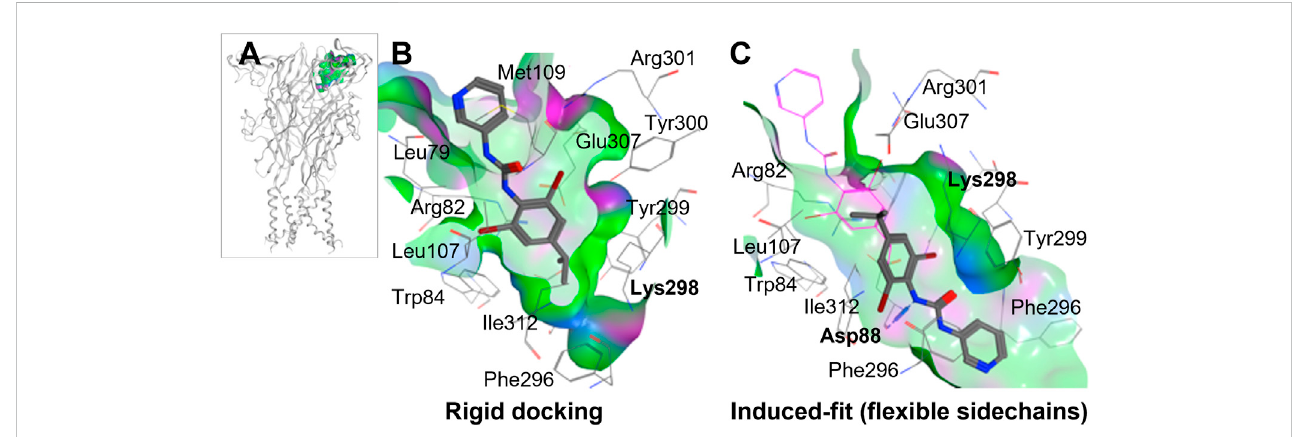
FIGURE 2 Molecular docking of BX430 into the allosteric pocket of human P2X4. (A) . Molecular model of human P2X4 showing the position of the pocket in the extracellular domain. (B – C) . Alternate binding poses of BX430 modelled into the allosteric pocket of human P2X4 using rigid (B) or induced- fi t (C) docking.